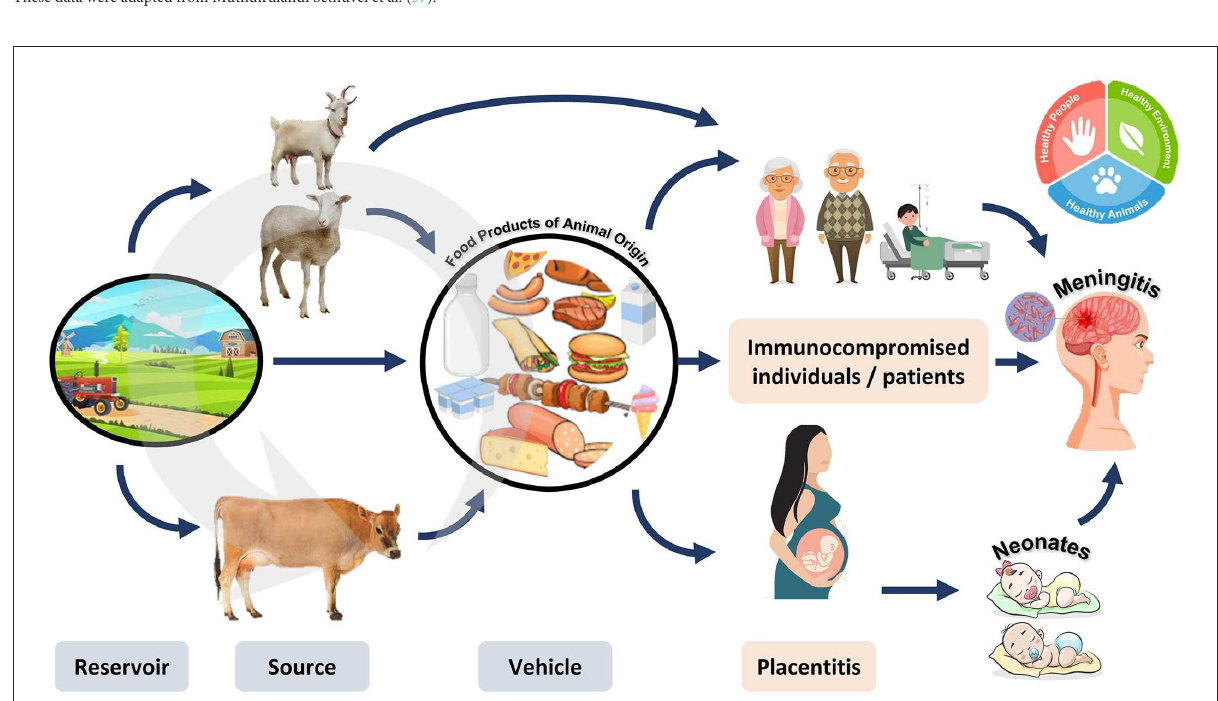
FIGURE8 Reservoir, transmission, and diseases caused by Listeria monocytogenes . Listeria monocytogenes can circulate in animals and the environment. The pathogen can be transmitted to humans by consuming contaminated animal products. The resulting disease is more dangerous in pregnant women (causing inflammation of the placenta leading to abortion), neonates, and immunocompromised individuals (causing meningitis).